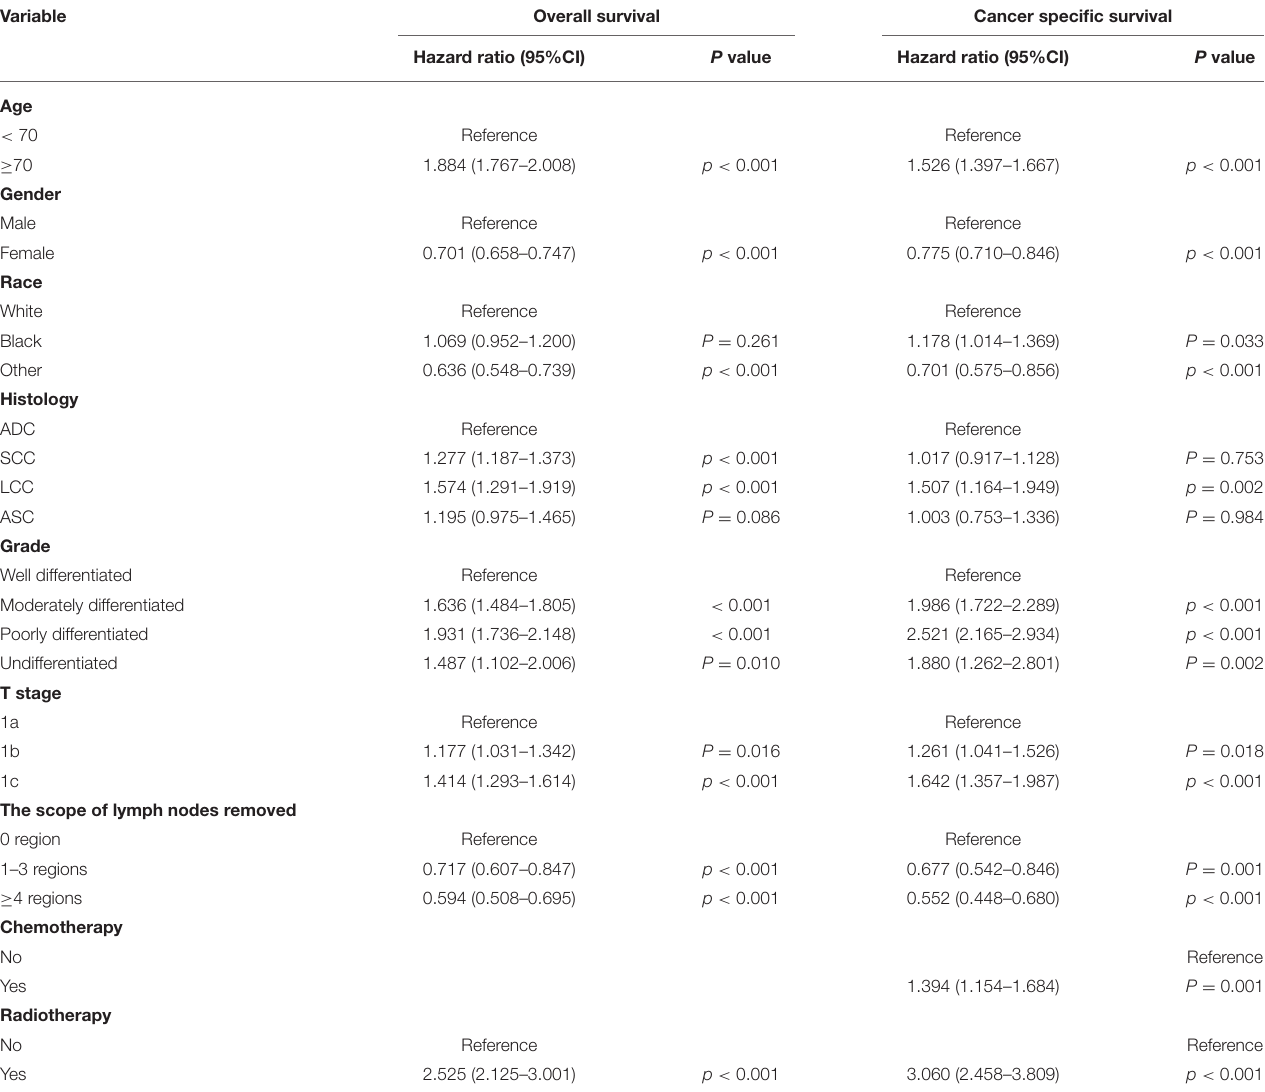
TABLE 4 | Multivariate analysis of overall survival and cancer-specific survival without the number of lymph nodes examined.